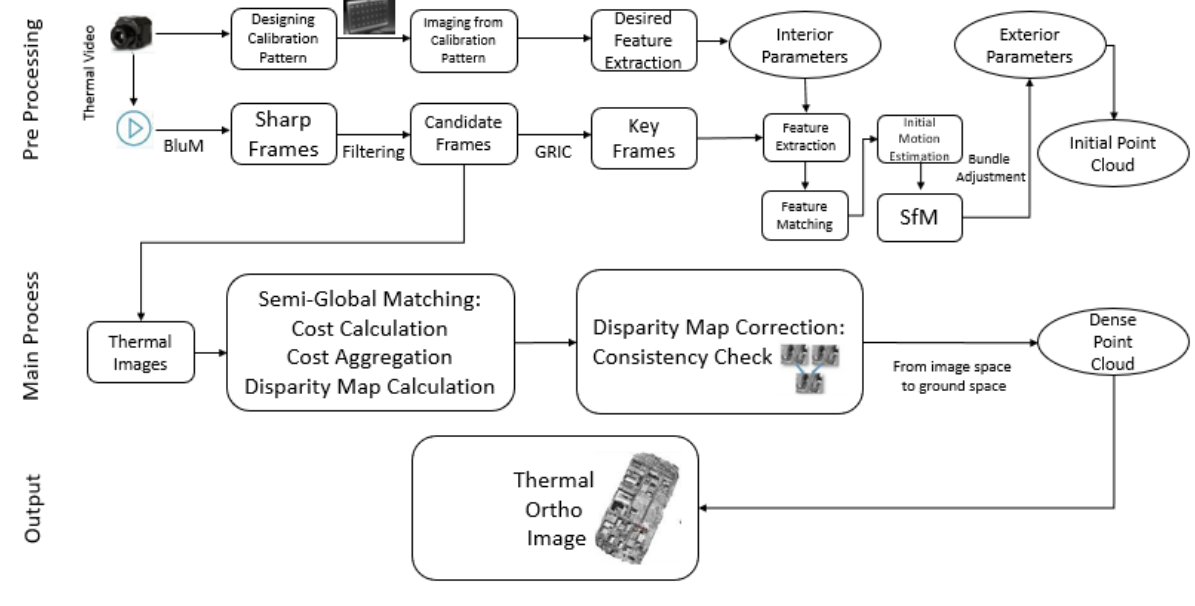
Figure 3. Flowchart of The Method